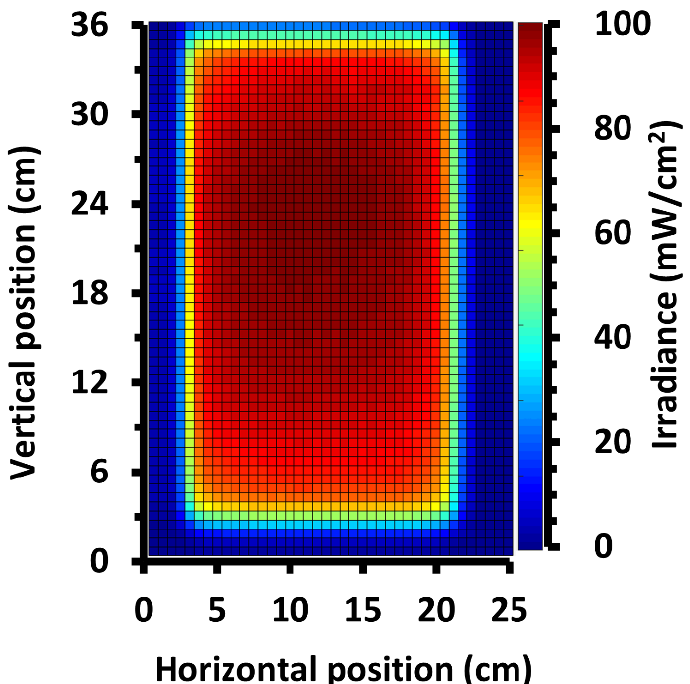
Figure 8. The measured irradiance uniformity map for a dual PCB LED LASS system using two diffusers: one, P-PY01, at 40 mm and the second one, C-CHH 30, at 140 mm from the LED SP. Class AAA performance is achieved in the red zone.